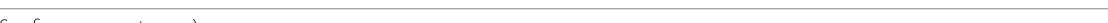
). D Degree of renal damage ×